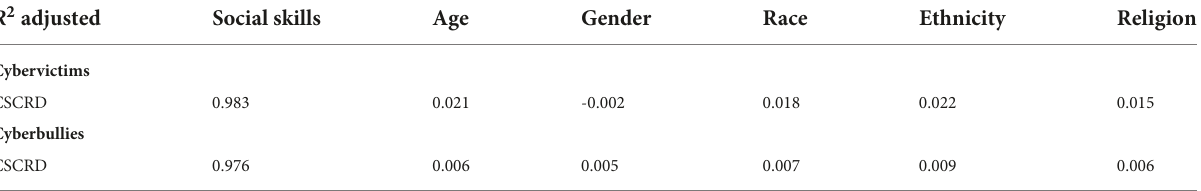
TABLE 9 Linear regressions for the variables social skills, age, gender, race, ethnicity, and